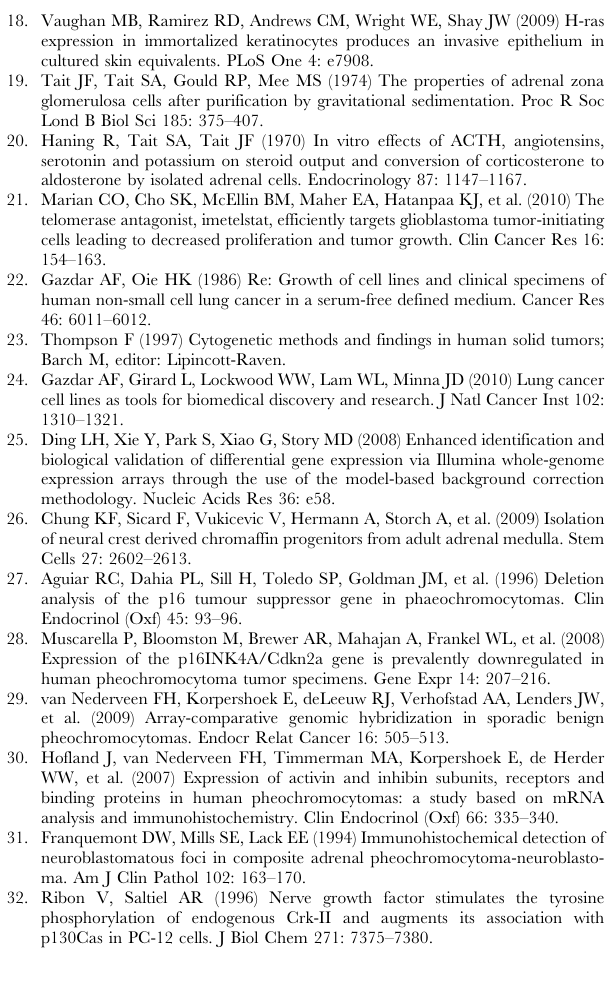
Figure S1 Telomeric Repeat Amplification Protocol (TRAP) assay. Like the positive control Hela cells, immortalized hPheo1 cells show evidence of telomerase activity. Figure S2 Molecular fingerprint for hPheo1. First column shows patient is a normal female XX. CSF1PO, D13S317, D16S539, D5S818, D7S820, THO1, TPOX, and vWA are microsatellite markers for fingerprinting analysis. hPheo1 is a new and unique cell line. Figure S3 Microarray comparing expression profiles of fibroblasts with hPheo1 cell line, pheochromocytoma tumor tissue, and normal adrenal medullary tissues. Expression profiles between hPheo1 cells, tumor tissue, and normal adrenal medulla show distinctly different expressions from fibroblasts. Figure S4 Fold change expression from shRNA knock- down. There is decreased expression of SDHB, RET, and COMT after shRNA knockdown.